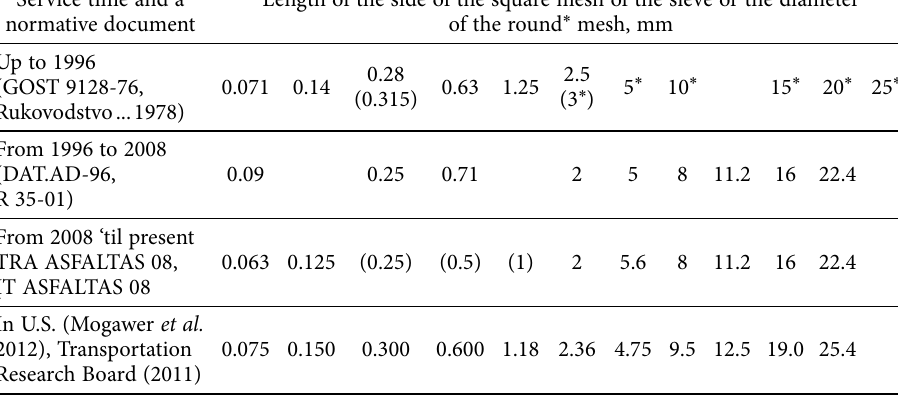
Table 3. The dynamics of changing the size of standard laboratory sieve mesh in the Republic of Lithu- ania Service time and a Length of the side of the square mesh of the sieve or the diameter normative document of the round * mesh, mm Up to 1996 (GOST 9128-76, 0.071 Rukovodstvo ... 1978)